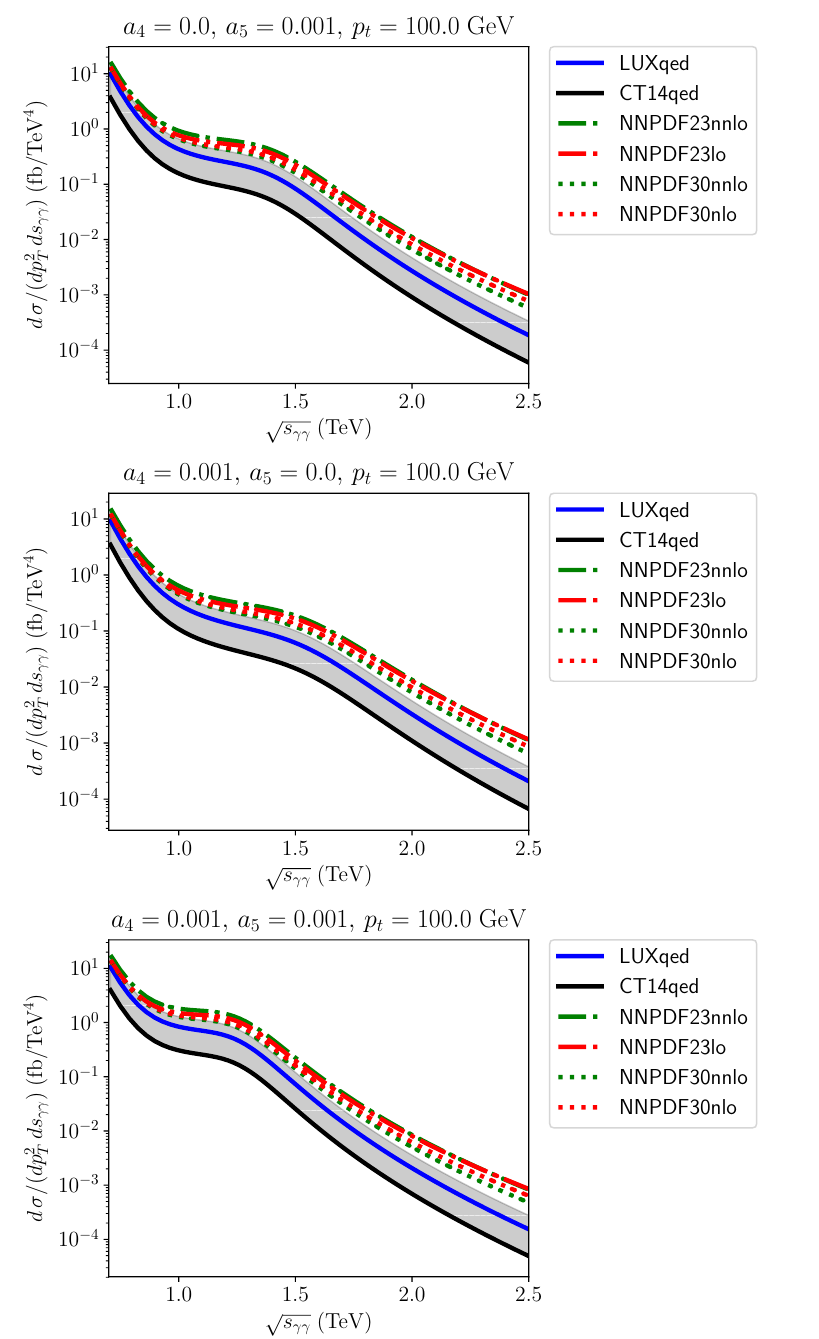
Figure 20 . Same as (cid:12)gure 12, with the CT14qed error bands. Both protons dissociate in the deeply inelastic regime. (E(cid:11)ective) PDF energy scale (cid:22) 2 = s (cid:13)(cid:13) . Open